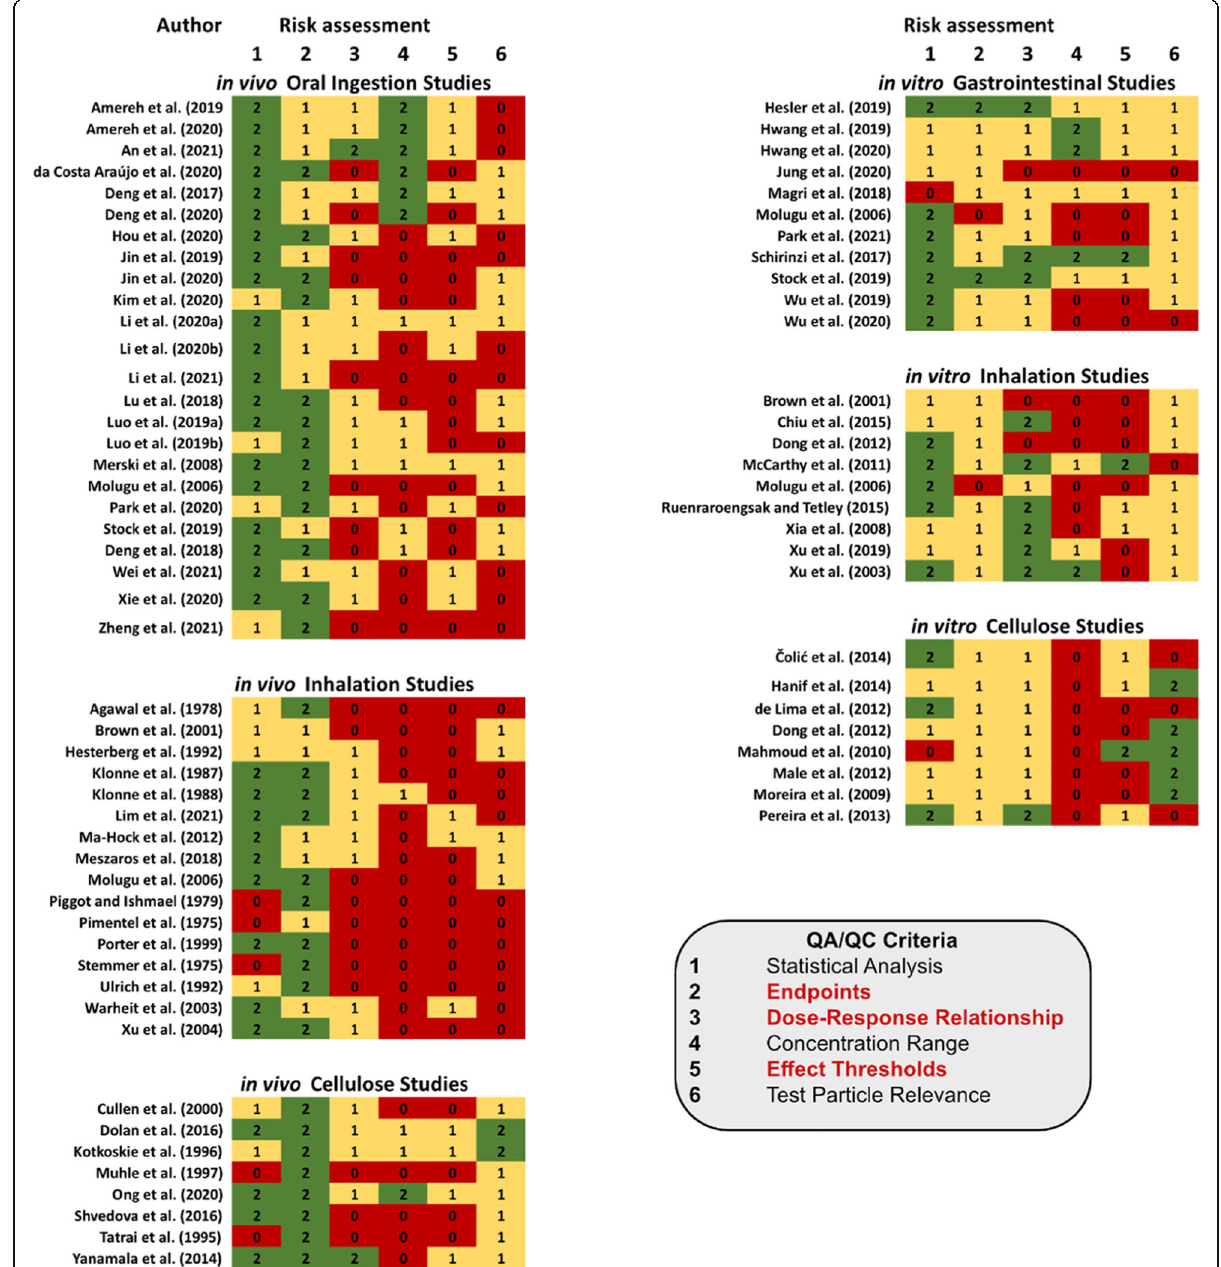
Fig. 4 Summary of evaluation scores for QA/QC criteria aligned with the reporting of data for use in assessing human health risks components of studies assessed by the NMP-TSAT. Please note that some studies report results for both in vitro and in vivo toxicity effects, such as Brown et al. [82], Molugu et al. [72], and Stock et al.